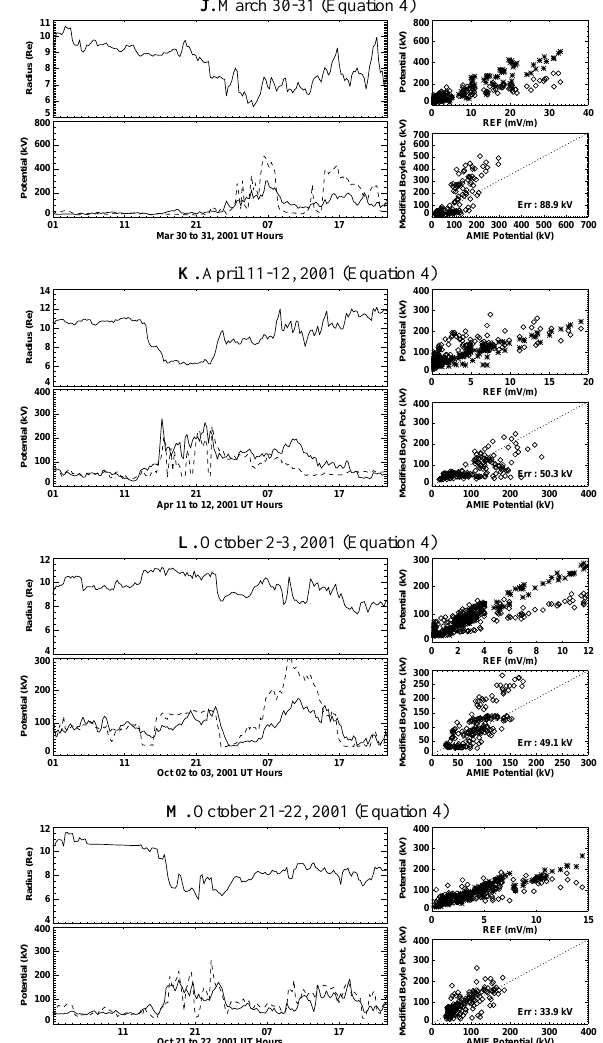
Fig. 8. The same four events in Fig. 4, plotted in the same way as Fig. 5.